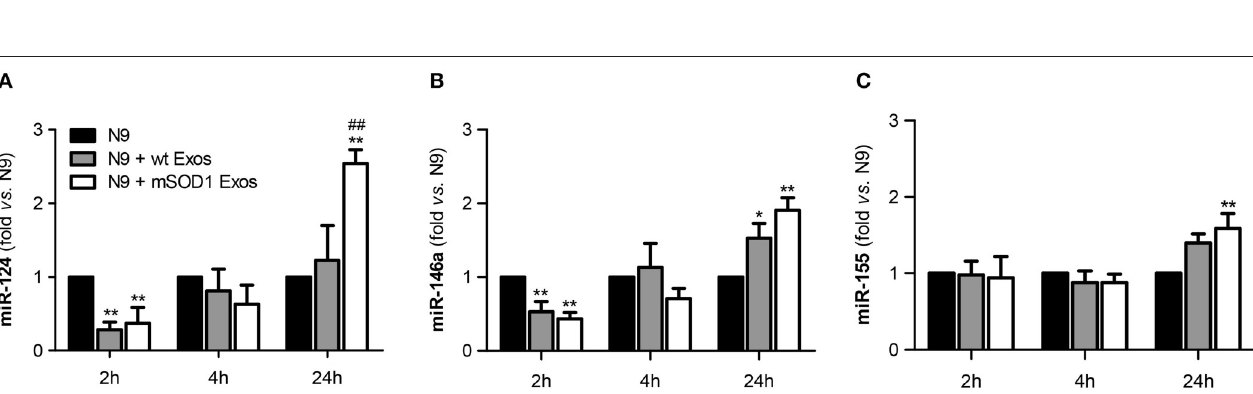
FIGURE 7 | Early decreased expression of calming microRNAs (miR-124 and miR-146a) is indicative of N9 microglia M1 phenotype, but their increase together with that of miR-155 suggests the coexistence of multiple activated phenotypes at 24 h. N9 microglial cells were incubated for 2, 4, and 24 h with exosomes (Exos) from wild-type (wt) NSC-34 MNs and mSOD1 NSC-34 MNs (N9 + wt Exos and N9 + mSOD1 Exos, respectively), as indicated in methods. Non-treated cells were considered as control. (A–C) Relative miR-124, miR-146a, and miR-155 levels were determined by qRT-PCR in total RNA. Results are mean ( ± SEM) from eight independent experiments and are expressed as fold changes relatively to non-treated microglia. Differences between the three different groups at each time point were obtained by one-way ANOVA followed by Bonferroni post-hoc correction. * p < 0.05 and ** p < 0.01 vs. non-treated cells; ## p < 0.01 vs. treatment with exosomes from wt NSC-34